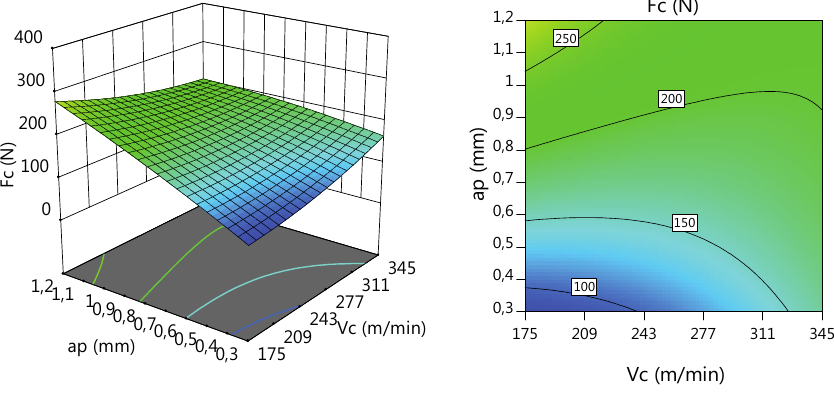
Fig. 21. Effect of cutting speed and depth of cut on cutting force, with feed rate